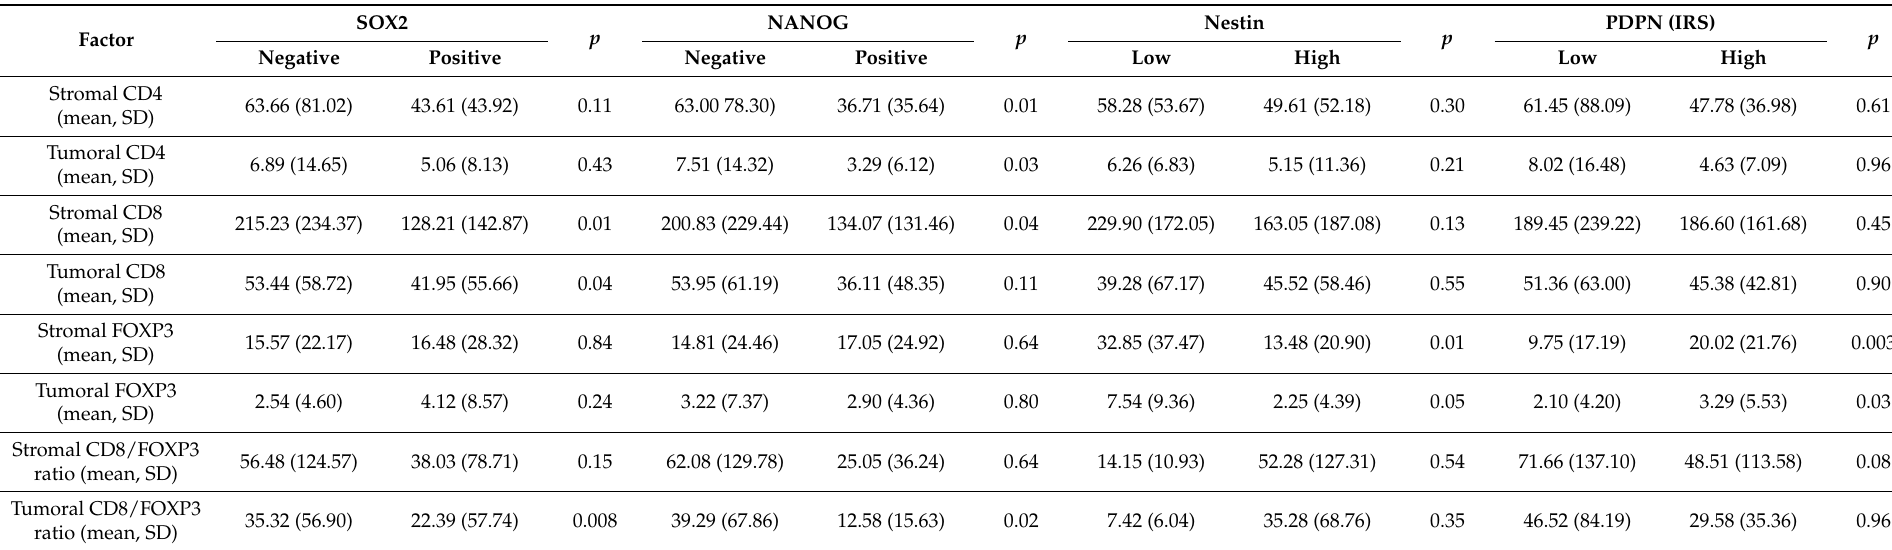
Table 2. Associations between tumoral and stromal CD4 + , CD8 + and FOXP3 + TILs and expression of CSCs